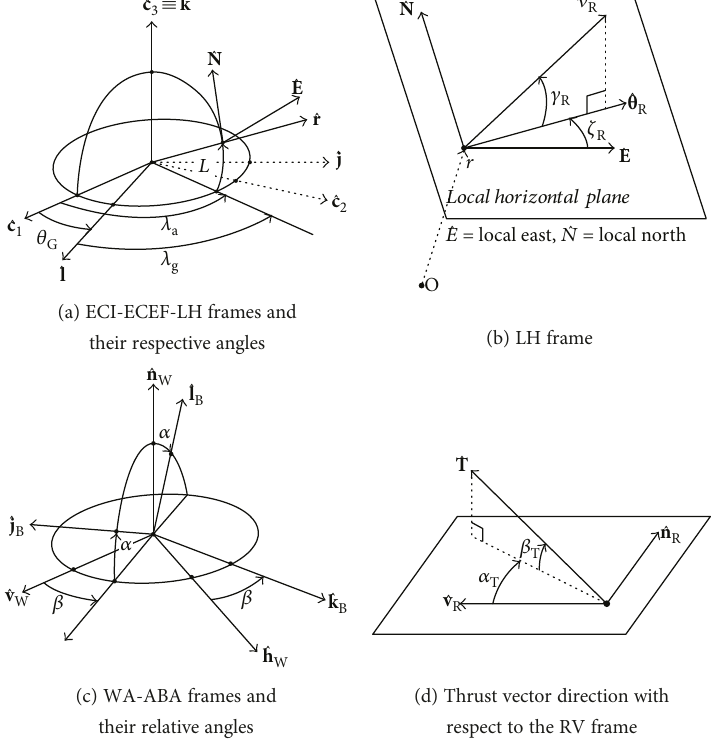
Figure 7: Main reference frames and related